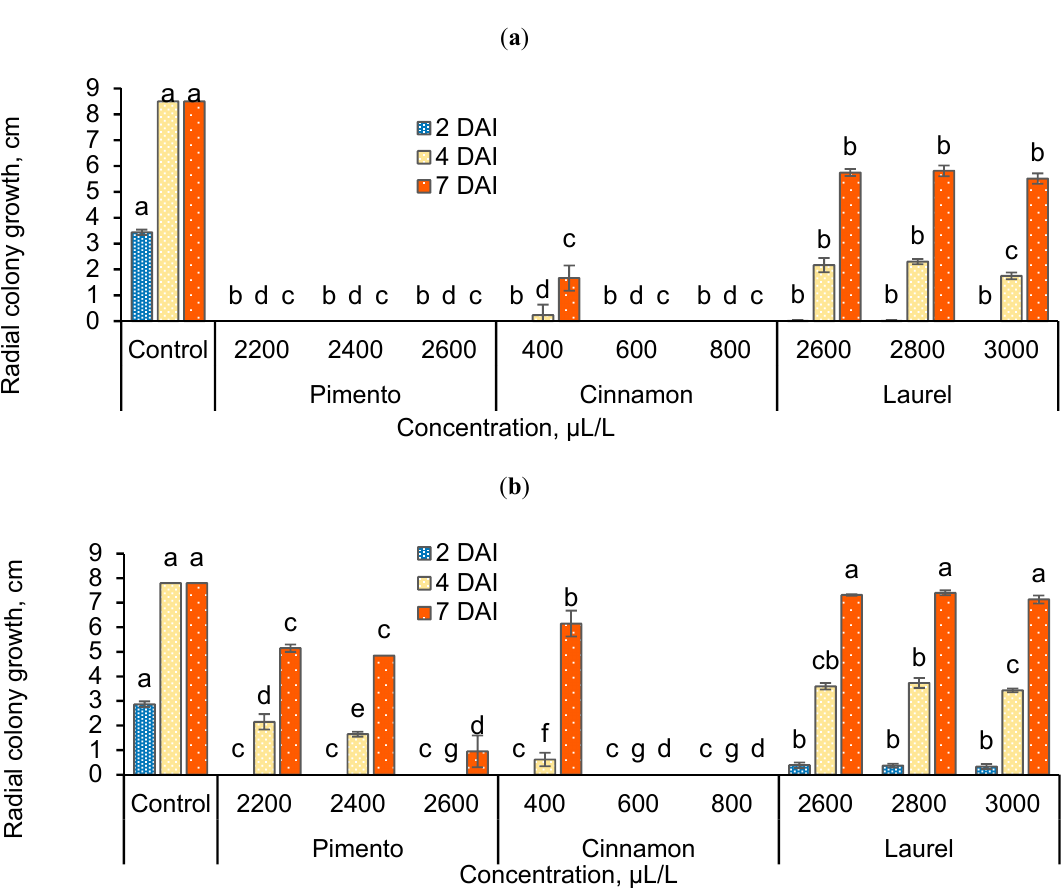
Figure 1. Radial colony growth (cm) on potato dextrose agar medium with different concentrations of extracts for Botrytis cinerea isolated from ( a ) strawberry and ( b ) apple. DAI—days after inoculation; the same letters indicate no significant differences between treatments according to Duncan’s multiple range test ( p < 0.05) at 2, 4, and 7 DAI.